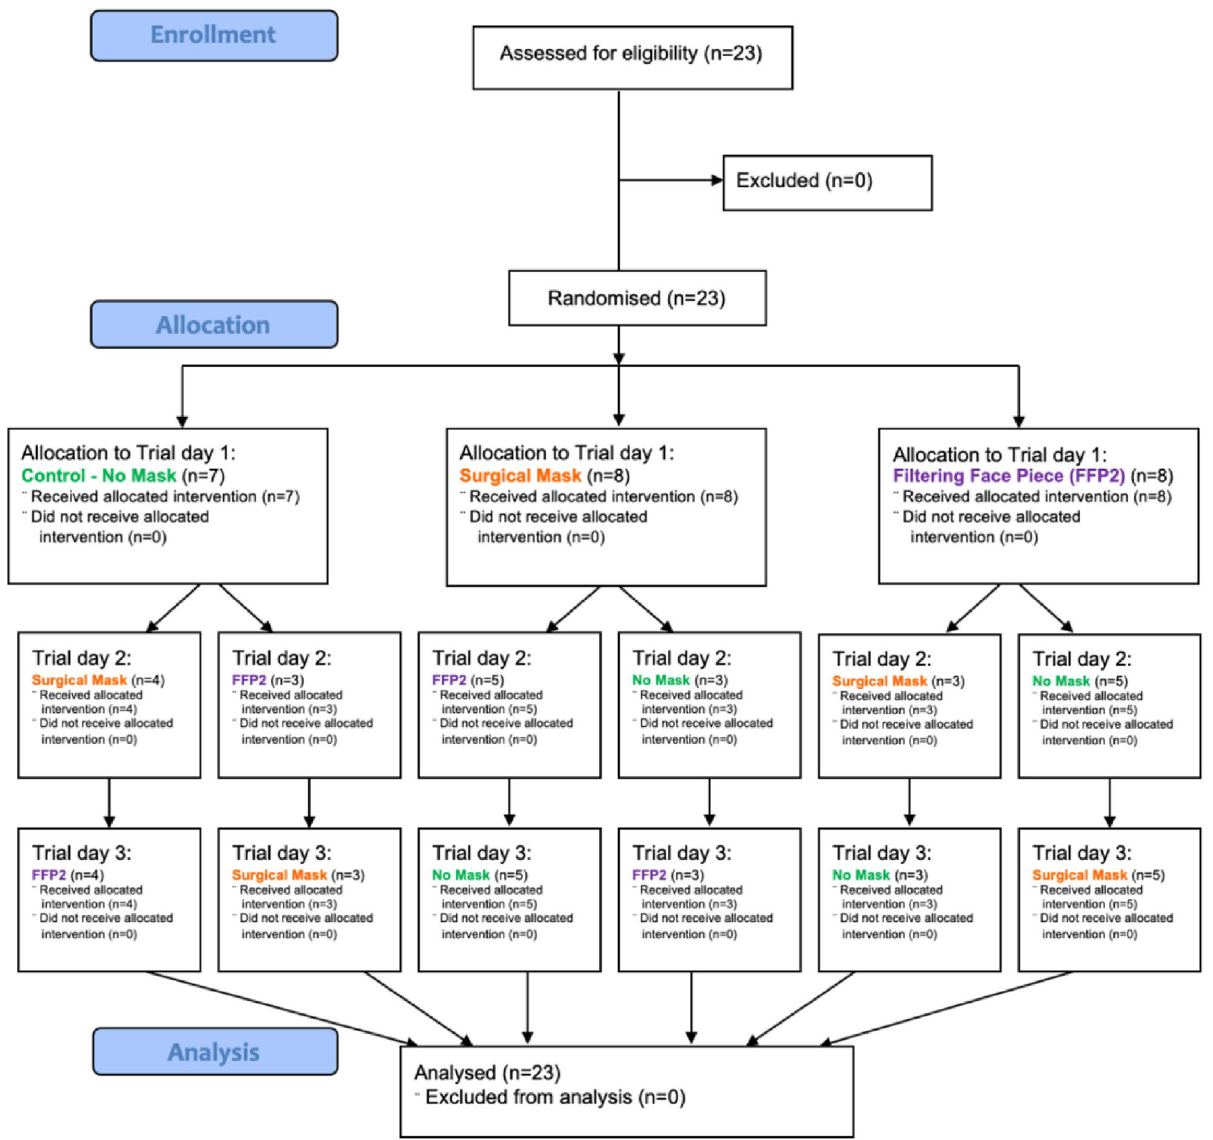
Figure 1. CONSORT flow diagram of the protocol procedures. Twenty-three participants were assigned to either the surgical face mask, the FFP2 mask or the unmasked condition by randomisation, followed by crossover to the other conditions. NM no mask, SM surgical mask, FFP2 Filtering Face Piece Type 2, CONSORT 2010 Consolidated Standards of protection (McAirlaid’s Vliesstoffe GmbH, Steinfurt, Germany). Both the surgical mask and the FFP2 (Ara Macao GmbH, Graben-Neudorf, Germany) were with ear loops and are available in public drugstores. Each session at each trial day consisted of a 20-min sitting phase and a 20-min steady state bicycle ergometer exercise at vigorous intensity (77% maximal HR) 22 . Each session was performed at a comparable time of the day (± 2 h) and at days with comparable routines (i.e. working days). Order allocation was done blinded, the participants were blinded to the respective manipulation until the beginning of each intervention. At each session, participants first rested for 20 min in a seated position without wearing a mask. The 20-min sitting phase followed; on a chair in reclined position. Here, the participants were allowed to read or use electronic devices. Between the sitting and ergometer intervention, there was a second 20-min resting period in which the participants were not manipulated (i.e. did not wear a mask). Afterwards, the bicycle exercise was performed, on an ergometer (Optibike med, ergoline GmbH, Bitz, Germany), at a constant cadence of 50–80 revolutions per minute (rpm). The intensity was set at 77% of the a priori estimated individual maximal HR during the first exercise manipulation 23 . Workload during interventions was 1.7 ± 0.4 Watt per kilogram bodyweight. During exercise, HR and perceived exertion were assessed each 3 min to control exercise intensity. Perceived exertion was assessed using a 15-point Borg Scale ranging from “very very light” (lowest rating 6) to “very very hard” (highest rating 20). Exercise should be perceived within the range of “somewhat hard” (rating 13) and “hard” (rating 16).